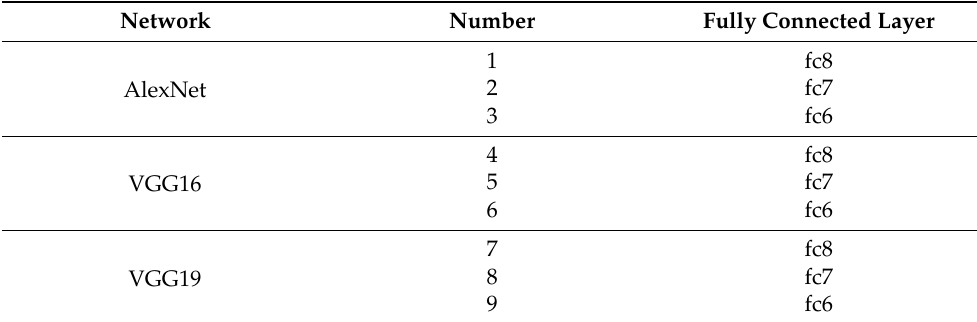
Table 8. Deep feature generation functions used in the Exemplar COVID-19FclNet9 model. Network Number Fully Connected Layer AlexNet